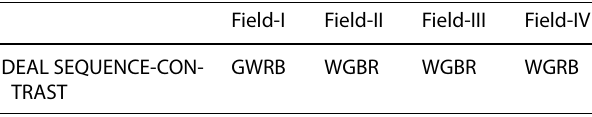
Table 1 Ideal contrast sequence (derived by digital image process- ing)